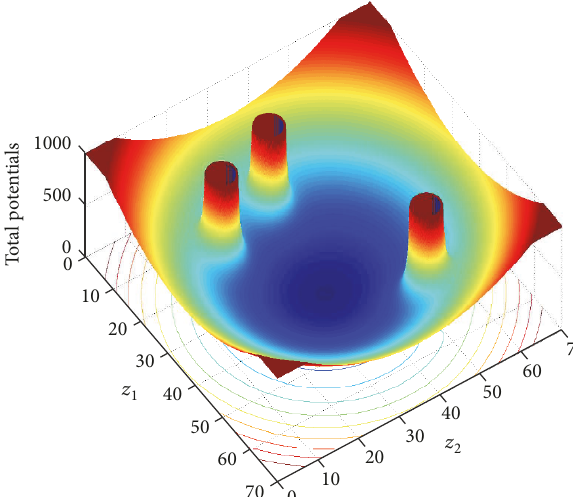
Figure 3: A three-dimensional view of the total potentials.